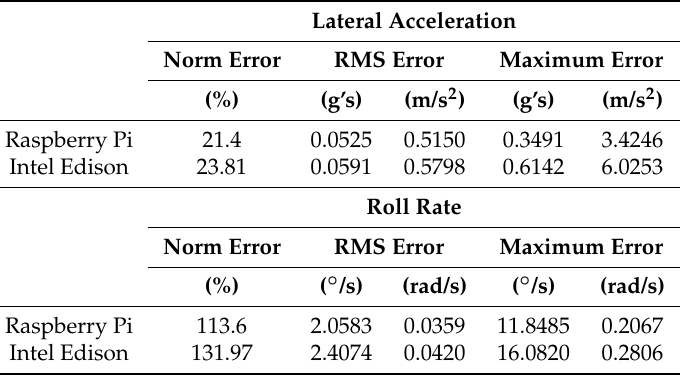
Figure 16. Test 3: Roll rate obtained from the IMU of VBOX (red points), from the IMU of Raspberry pi (blue points) and from the IMU from Intel Edison (green points). Table 9. Test 3: Errors of lateral acceleration and roll rate data for the accelerometers and gyroscopes mounted on Raspberry Pi and Intel Edison compared with the IMU from VBOX (ground